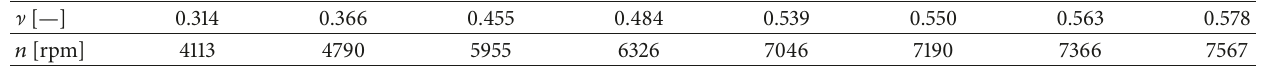
Figure 6: Circumferentially averaged meridional streamlines for radial and bow stators. Table 5: The operating points of rotating speed as a variable in the range of run number ] between 0.3 and 0.6.